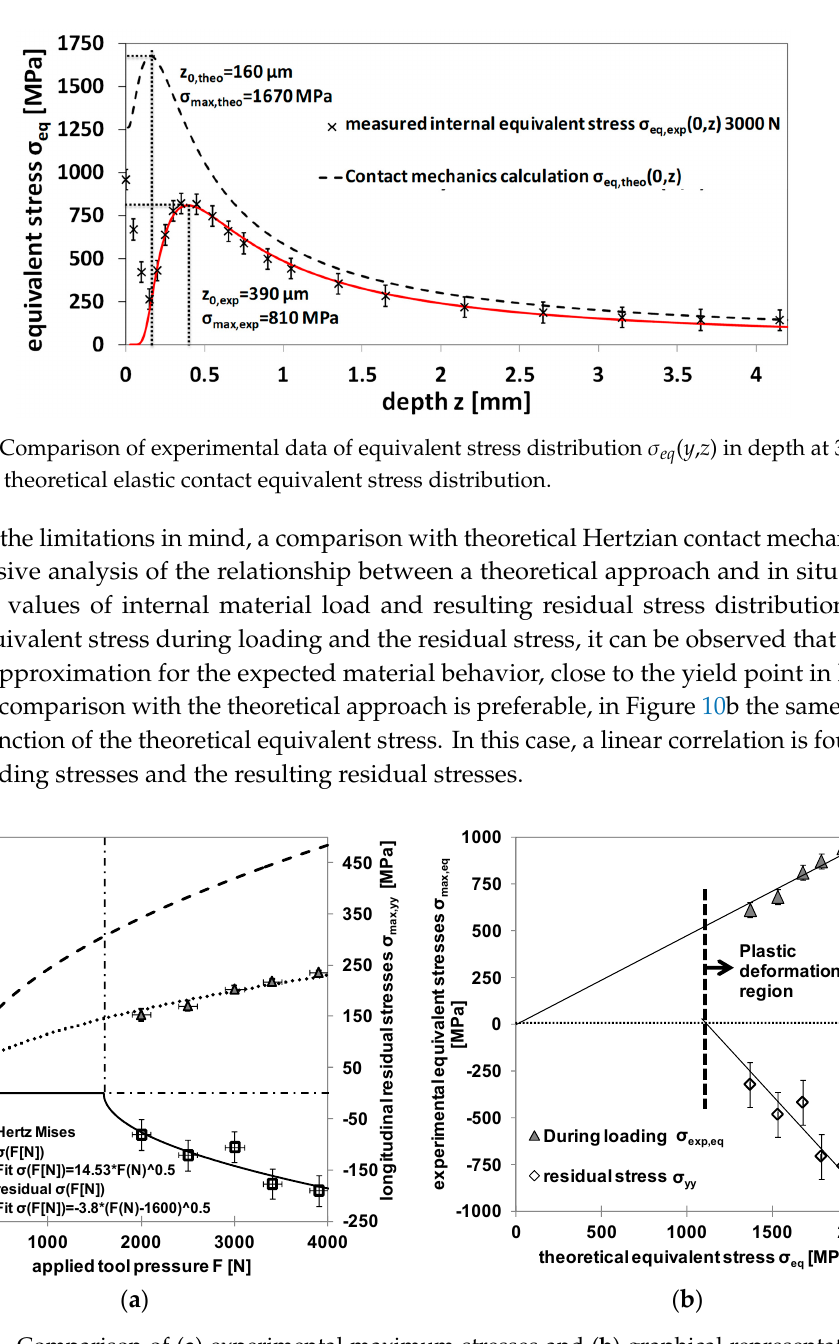
σ eq , theo , max (0, z